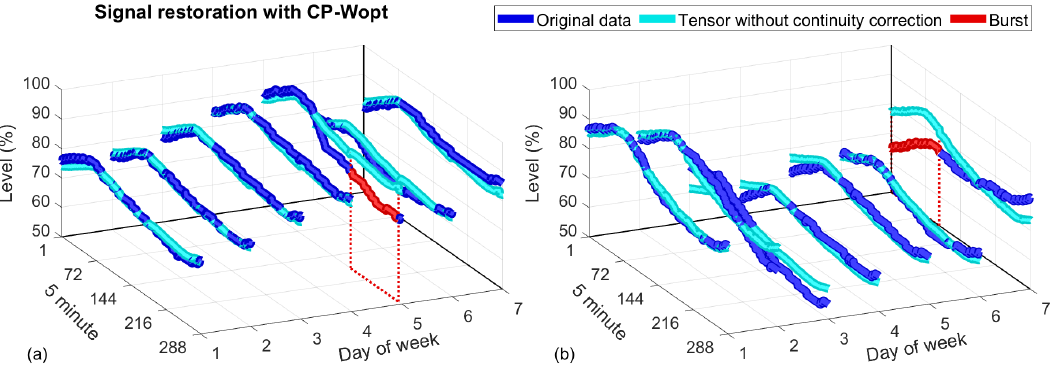
Figure 7. A particular case to show the performance of the CP Weighted OPTimization (CP-Wopt) algorithm when recovering two missing bursts in a χ 288 × 7 × 3 tensor. The original signal is shown in blue, the section corresponding to the erased burst is in red, and the result of the algorithm is displayed in cyan. ( a ) Shows the data in χ ( :, :,1 ) corresponding to week 1, and ( b ) shows the data in χ ( :, :,2 ) corresponding to week 2. It can be observed that the output of the CP-Wopt algorithm follows the variations (the first derivative) of the original data, although with some points differing.